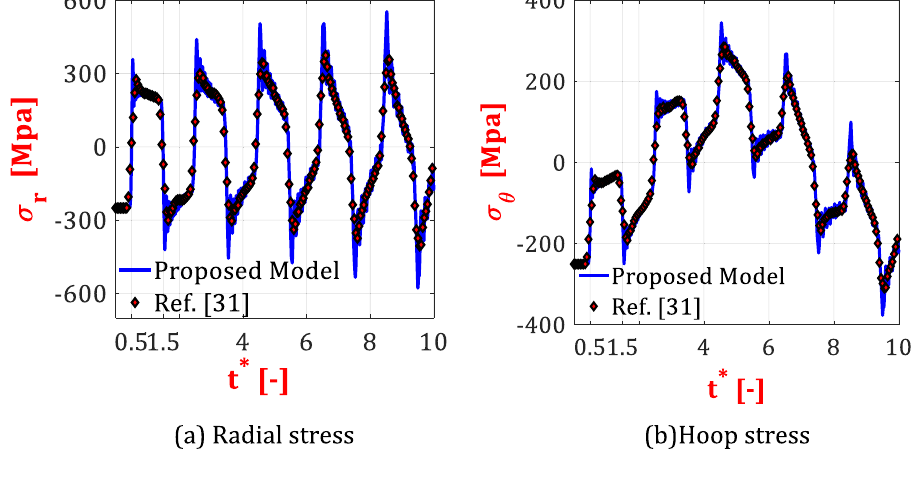
Fig. 3 Stresses-time history at the mid-radial